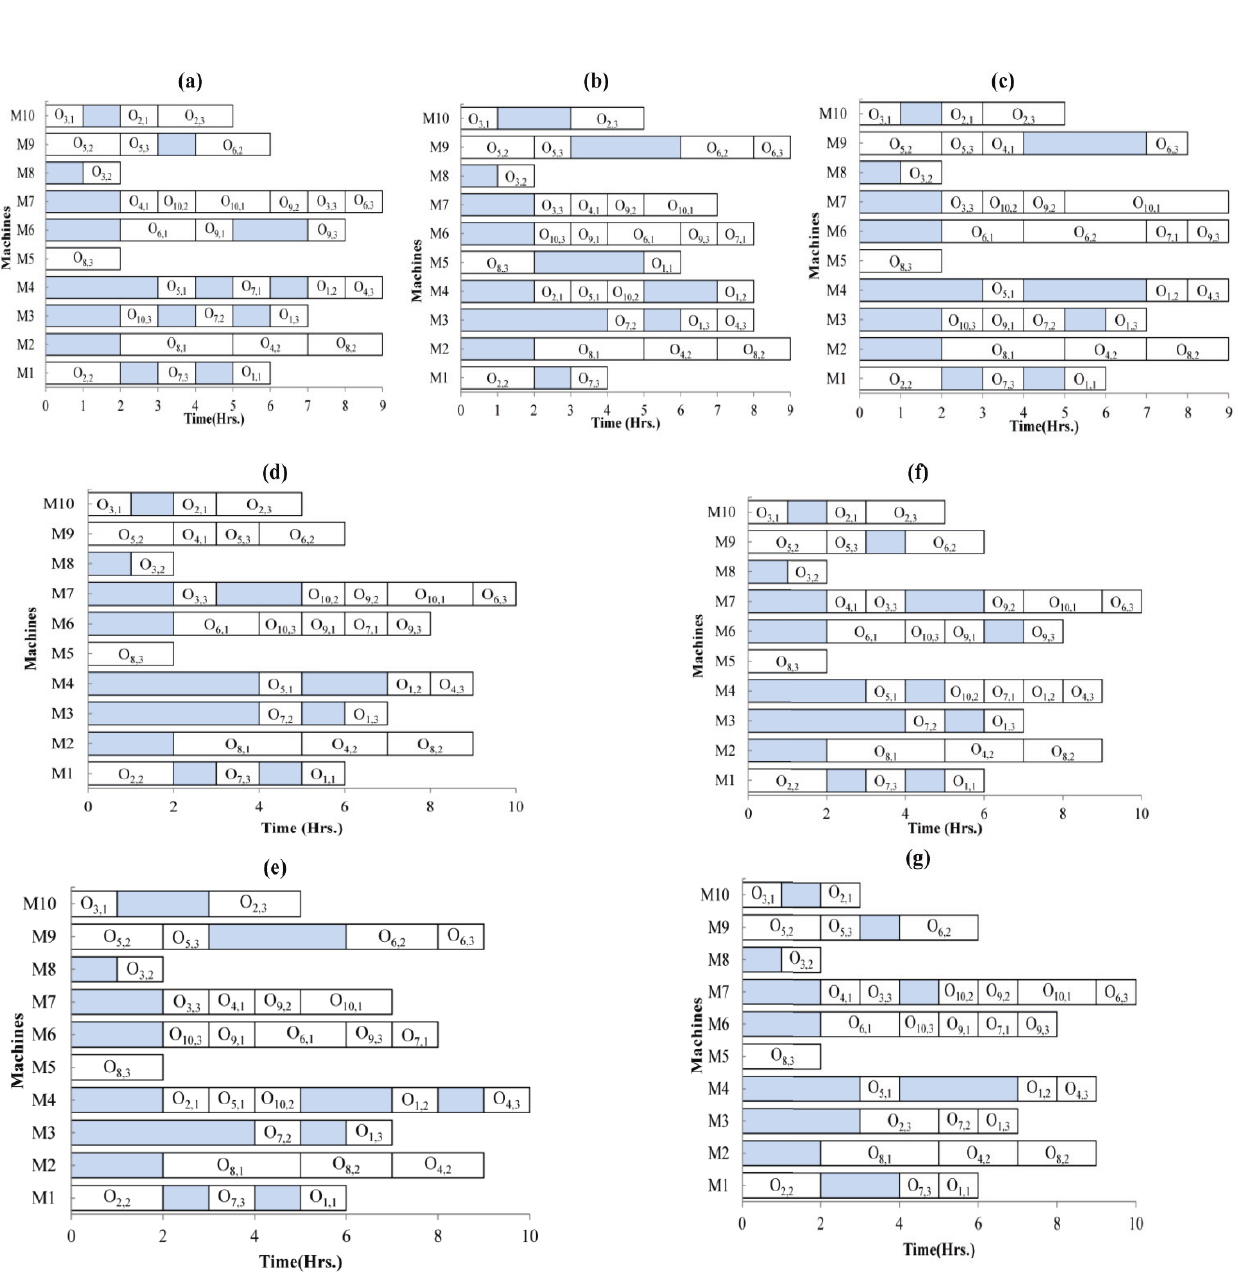
Fig. 10 Gantt charts for Mesghouni